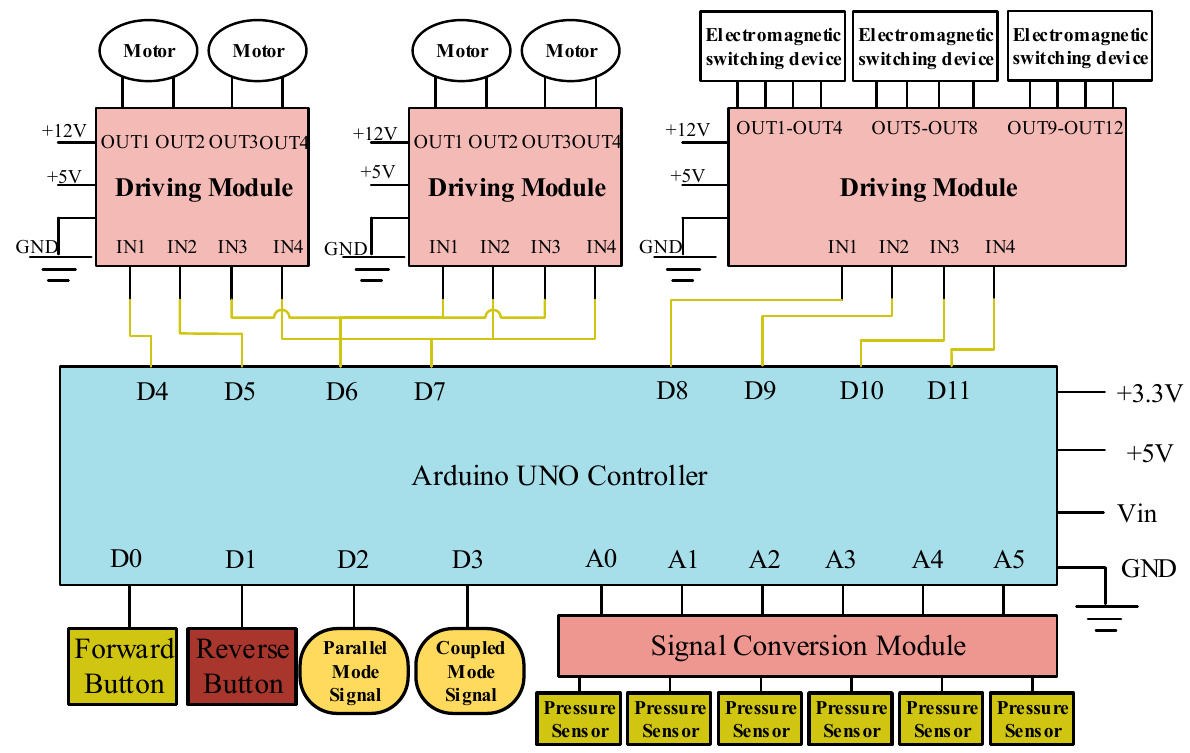
Figure 18. Schematic diagram of the ESMGM robot hand sensor control system. The controller drives the motors and electromagnetic switching devices through digital I/O interfaces, and the motion of three fingers occurs simultaneously. Digital I/O interfaces D0 to D3 detect the grasp signal, release signal, parallel mode signal, and coupled mode signal, respectively. Analog I/O interfaces A0 to A5 read analog signals converted by the conversion module from pressure sensors. In the process of the ESMGM robot hand working, the operator should first select the grasping mode, and the system will automatically set it to the selected working mode. After that, the control system will wait for the trigger of the grasp signal or release signal to complete the grasping action or release action. When the distal phalange of the ESMGM robot hand contacts the object, it will produce a force on the object. The pressure sensor detects the change in pressure. When the pressure value is greater than the set value, the robot hand automatically stops grasping. During the release action, when the ESMGM fingers return to their initial position, the process will end